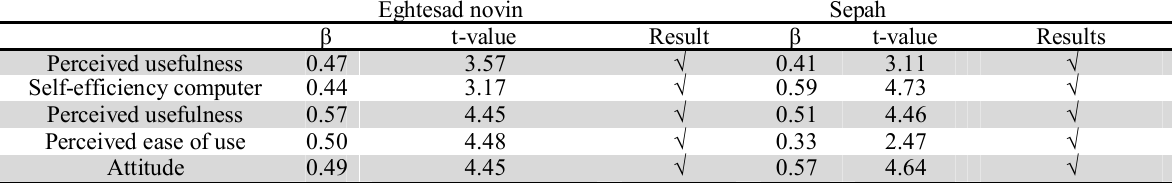
The summary of t-student values for the implementation of structural equation modeling Eghtesad novin Sepah β t-value Result β t-value Results Perceived usefulness 0.47 3.57 Perceived